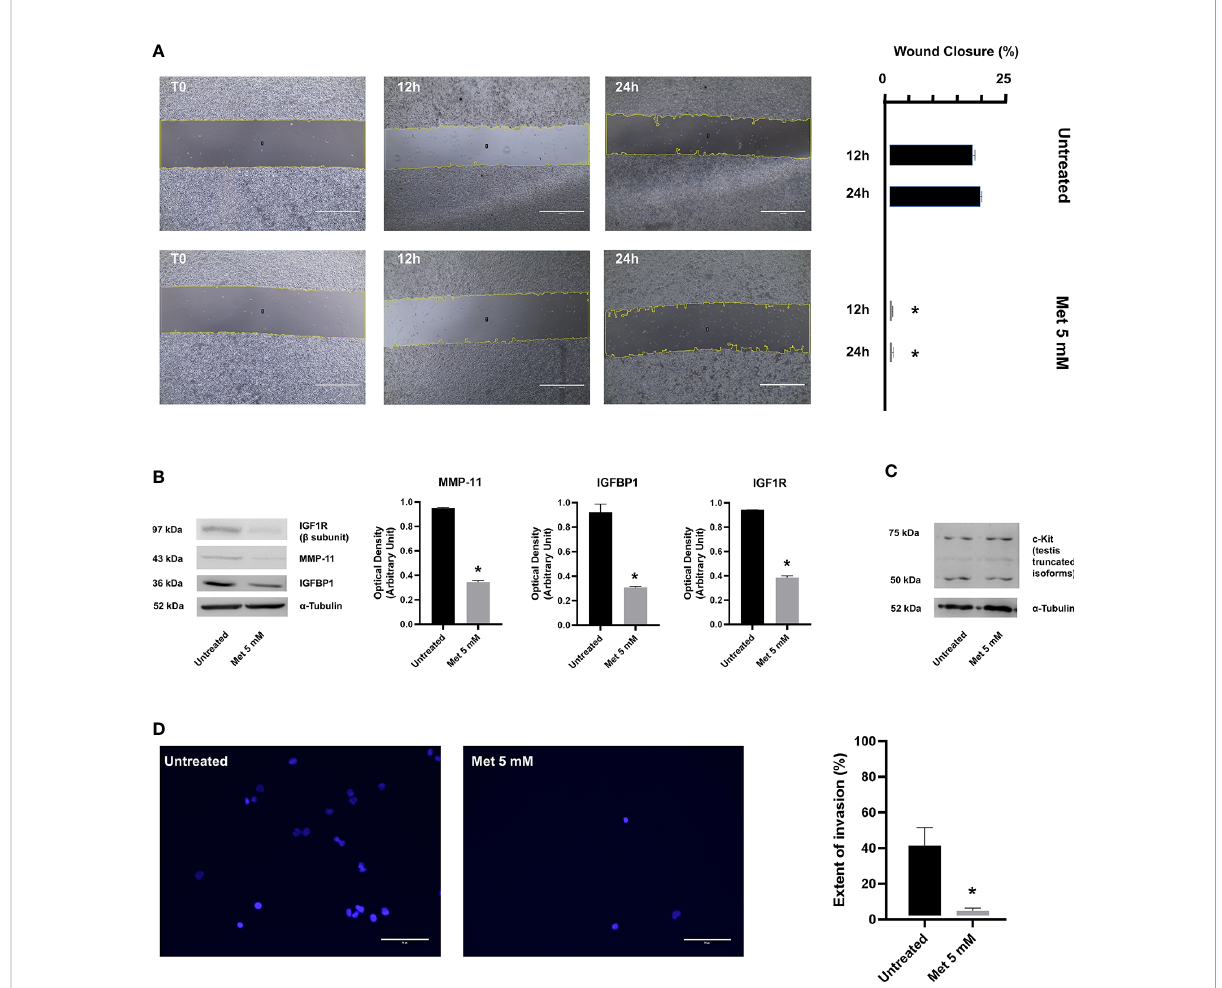
FIGURE 3 (A) Wound healing assay was performed to determine the migratory ability of SEM-1 cells during 24 h treatment with 5 mM Met. Wound closure was quanti fi ed as the relative percentage reduction of the wound area to time 0 (T0) at 12 h and 24 h of Met treatment, using the Image J software. Scale bar: 1000 µm. Histograms are representative of three replicates. * p < 0.05 vs untreated cells (black bars) at each time point. (B) Representative immunoblots of protein factors MMP-11, IGFBP1, IGF1R. Expression levels were normalized to a -Tubulin and quanti fi ed as relative arbitrary units. * p < 0.05 vs untreated cells (black bars). (C) A representative immunoblot of truncated c-Kit isoforms is shown. (D) Transwell assay was performed to determine the invasion ability of SEM-1 cells during 24 h treatment with 5 mM Met. Extent of invasion was determined as the proportion of seeded cells that adhered to the bottom well plate. The average cell count in fi ve microscopic fi elds per well was performed using the Image J software. Scale bar: 75 µm. Differences between proportions were compared using the Chi-square test. * p < 0.05 vs untreated